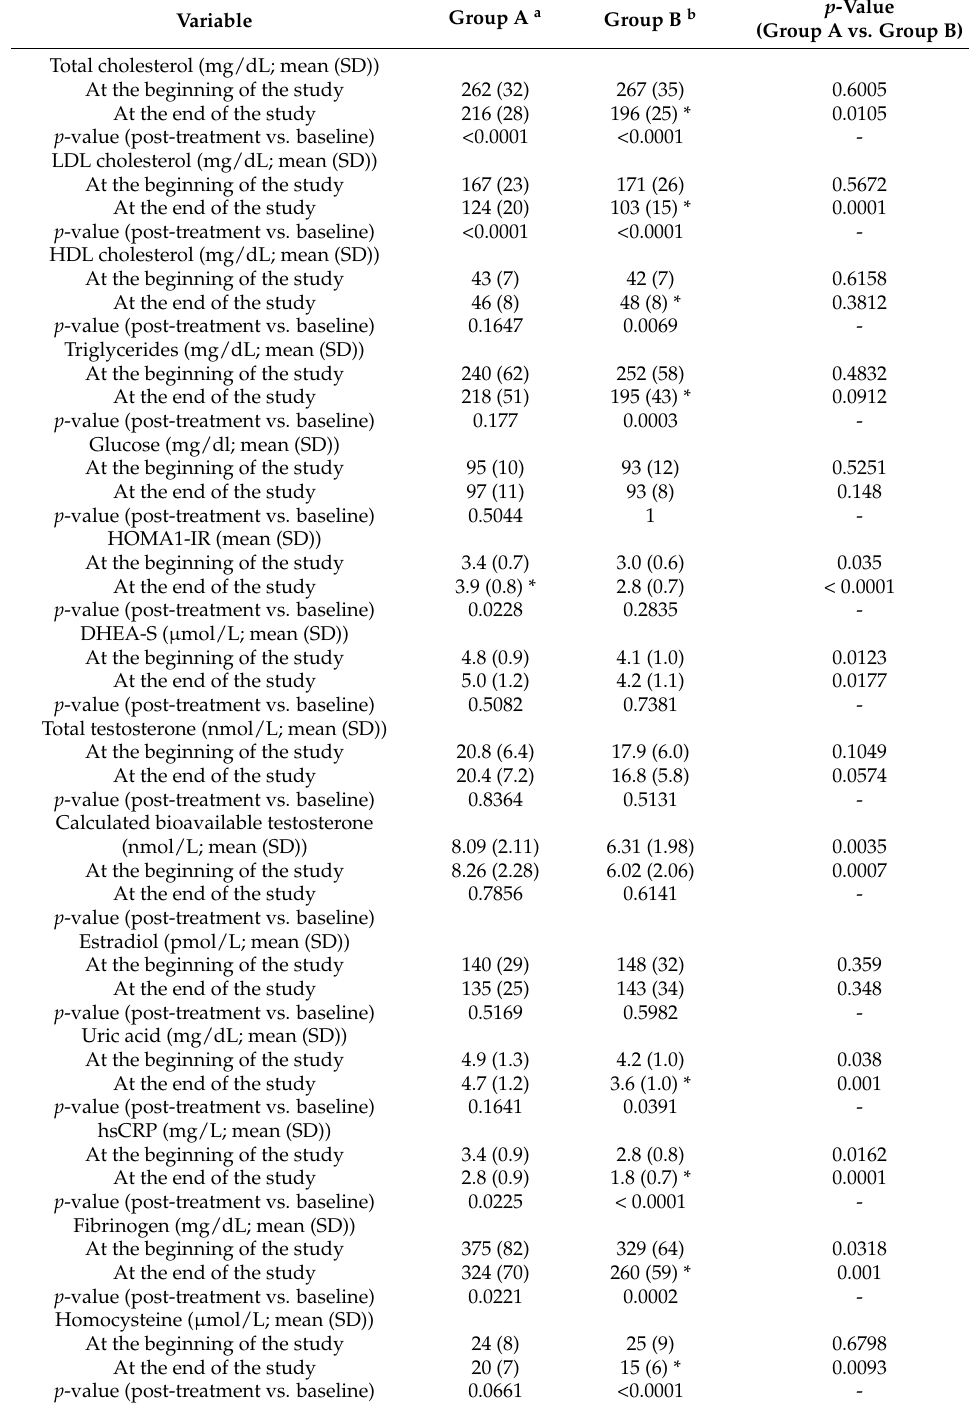
Table 2. The effect of rosuvastatin on plasma lipids, glucose homeostasis markers, hormones, and the investigated cardiometabolic risk factors in young men with mixed